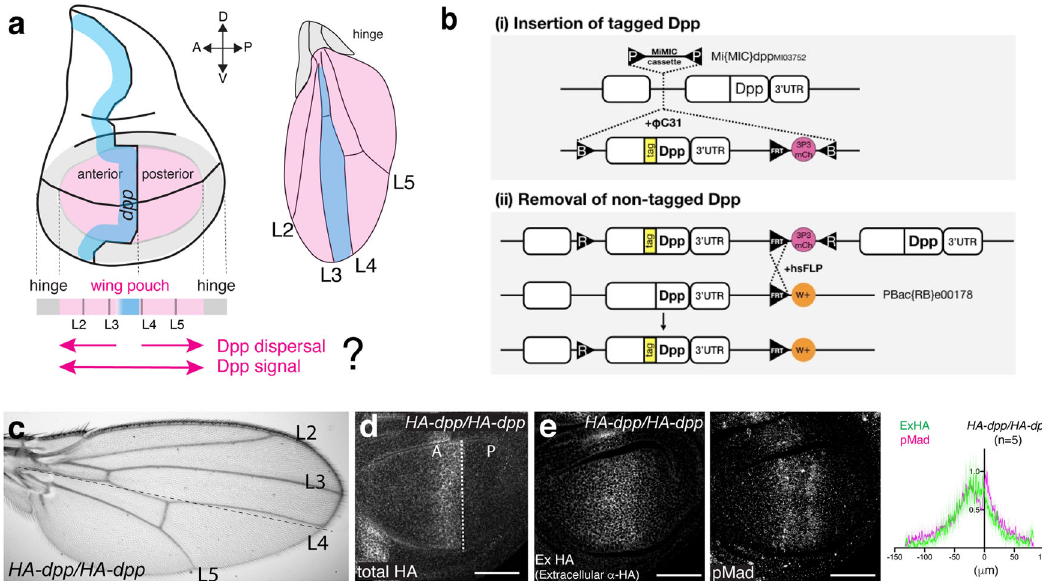
Fig. 1 Generation of a functional HA-dpp allele. a A schematic view of the wing disc and the adult wing. b A schematic view of a platform manipulating endogenous dpp locus. c Adult wing of a homozygous HA-dpp fl y. d Conventional α -HA staining of HA-dpp homozygous wing disc. e Extracellular α -HA staining (Ex HA) and α -pMad staining of HA-dpp homozygous wing disc. Average fl uorescence intensity pro fi le of extracellular HA and pMad staining of HA-dpp/HA-dpp wing disc ( n = 5). Data are presented as mean ± SD. Scale bar 50 μ